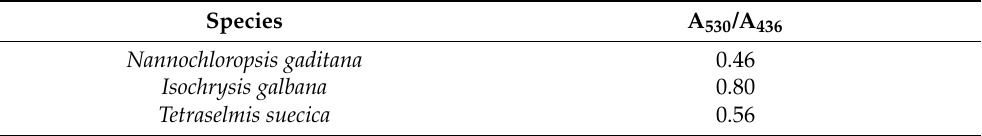
Table 3. Relationship between absorption at 530 nm and 436 nm for the phytoplankton species stud- ied.